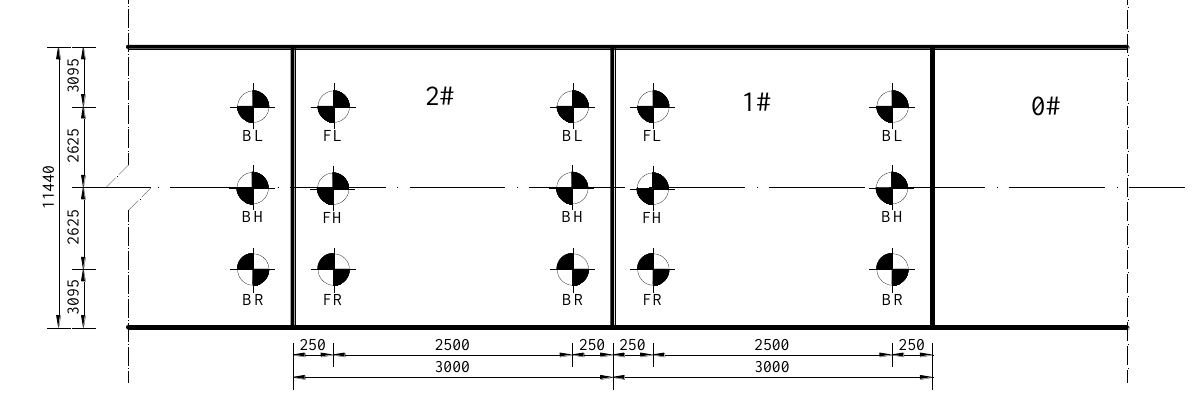
Figure 16. Measuring point on the beam.